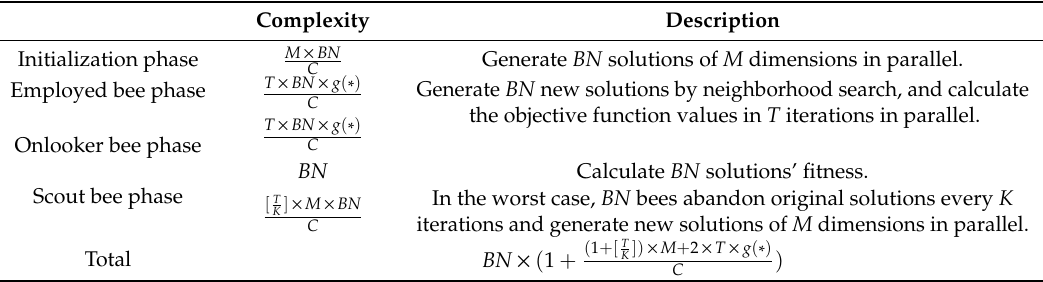
Table 1. The Time Complexity of the